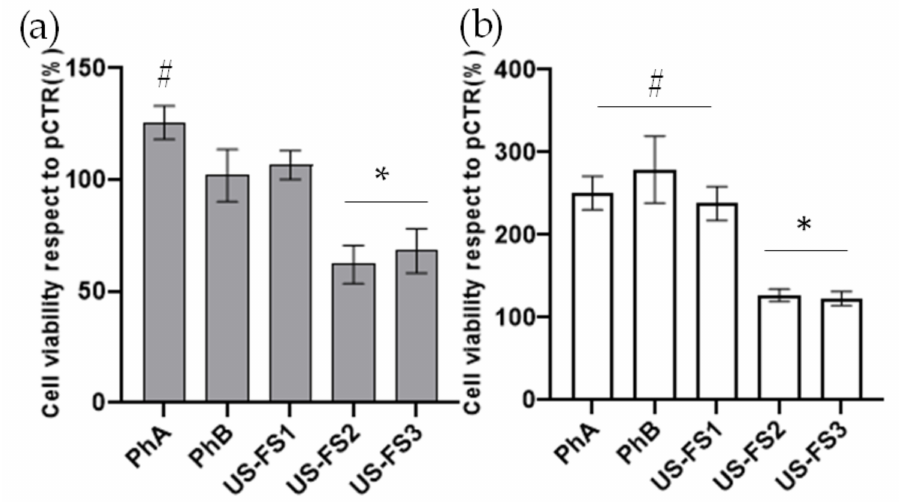
Figure 3. MTT assay to evaluate cell viability after 48 h of treatment. Metabolic activity performed on chondrocyte ( a ), and synoviocyte ( b ), treated with US FS in comparison to PhA and PhB pharma grade chondroitin sulfate based products. The values presented are the averages ± S.D. For chondrocytes ( a ) significant differences are indicated as # p < 0.05 vs. pCTR, and * p < 0.01 respect to PhA and PhB. For synoviocytes significant differences are # p < 0.01 vs. pCTR and * p < 0.01 vs. PhA, PhB and